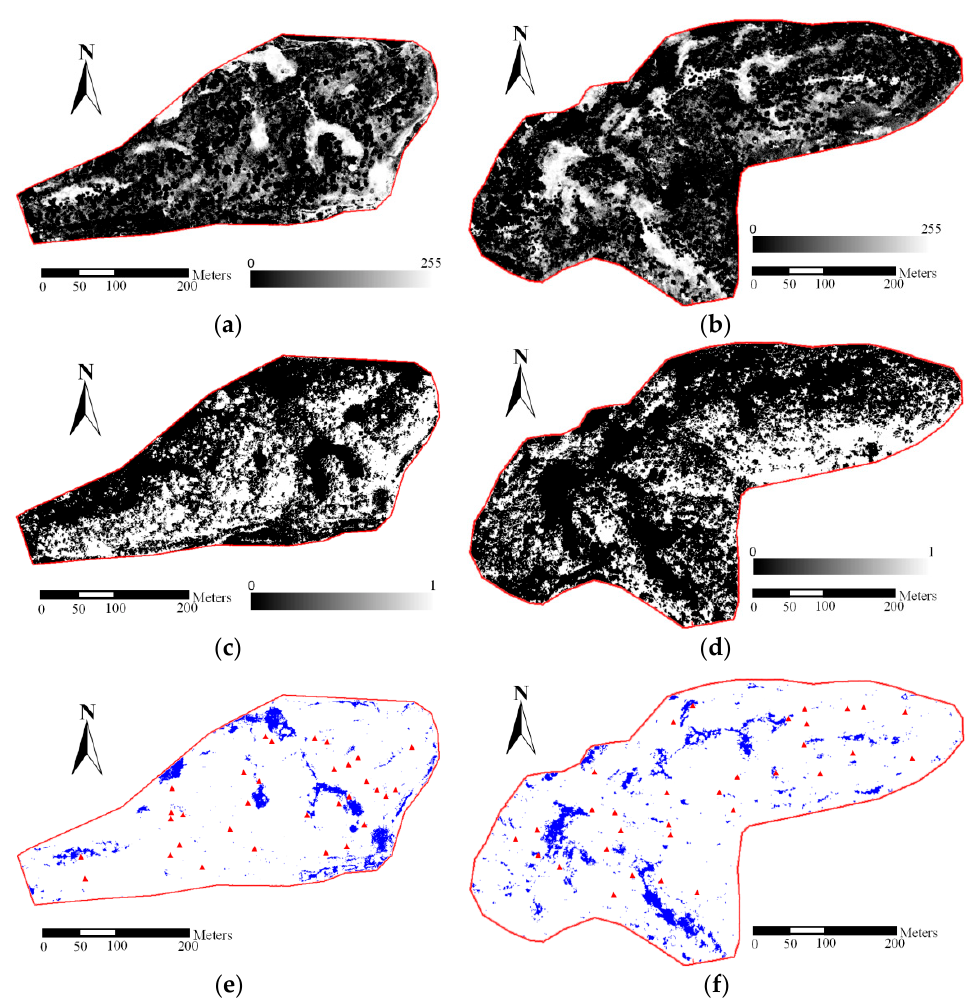
Figure 4. BEI maps, SI maps, and BEPs of the two forest plantations. ( a ) and ( b ) are the BEI intensity maps of Plantations 1 and 2, respectively. ( c ) and ( d ) are the shadow masks of Plantations 1 and 2, correspondingly. The BEPs of Plantations 1 and 2 are marked in ( e ) and ( f ), respectively. Red triangles denote the sample trees, red line denotes the boundary of each plot, and the blue pixels denote the BEPs. BEI: bare-earth index; SI: shadow index; BEPs: bare-earth points.